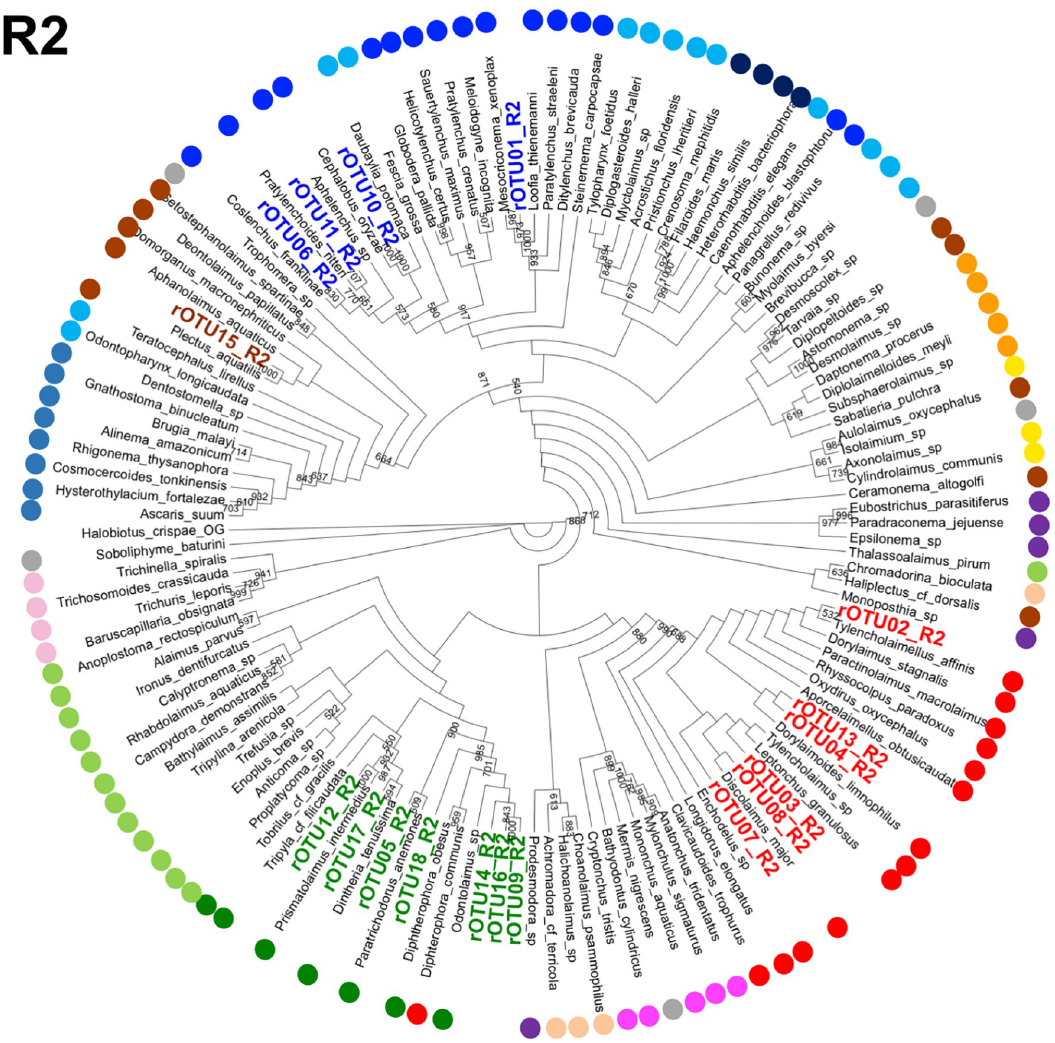
Fig 6. A cladogram of phylogenetic tree generated by regional SSU nucleotide sequences from reference nematode species and regional rOTUs corresponding to region 2. The phylogenetic trees were prepared using regional sequences of the reference nematode species and the regional rOTUs corresponding to region 2 (R2) as described in Materials and methods. Orders of the reference species are indicated by colored dots, as shown in the legend for Fig 5.